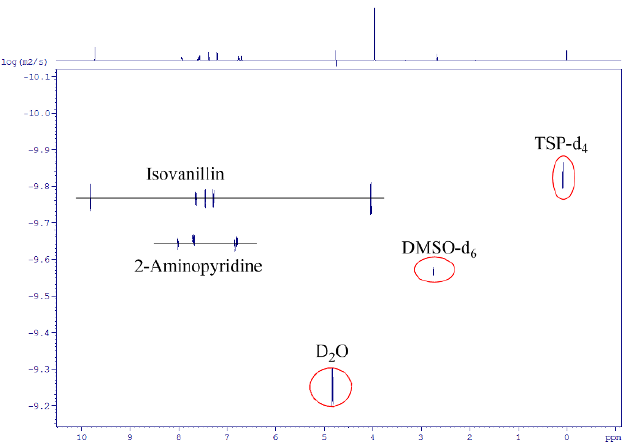
Figure 6. 2D-DOSY NMR spectrum of 2-aminopyridine and isovanillin with BSA, where the X-axis contains the standard 1 H-NMR chemical shifts, while the y-axis contains the diffusion dimension. Spectrum produced as a result of total diffusion time ( ∆ ) of 80 ms, 5 ms of eddy current and 1000 µs of small delta ( ∂ ). The area in a circle represents the diffusion coefficient of reference solvents (D TSP-d ) while, the solid straight lines represent the molecules of 4